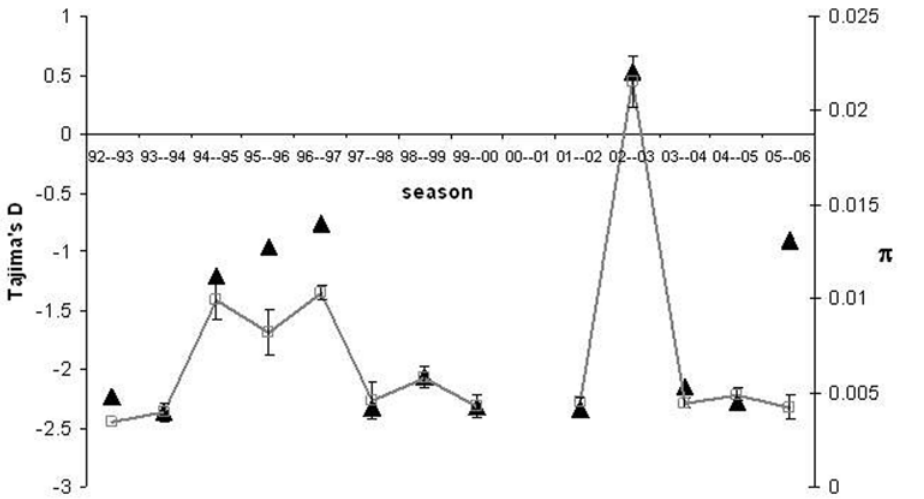
Figure 7. Pattern and level of genetic diversity in the coding region of hemagglutinin gene of A/H3N2 influenza virus. Sequences sampled in New York State, USA, over several seasons, in which a season was defined as the time-window between September and May. Across the time period analysed Tajima’s D (full triangles) is negative but in 2002–2003 we can observe that Tajima’s D achieves a positive value which accompanies an increase in genetic diversity p (represented as open squares).